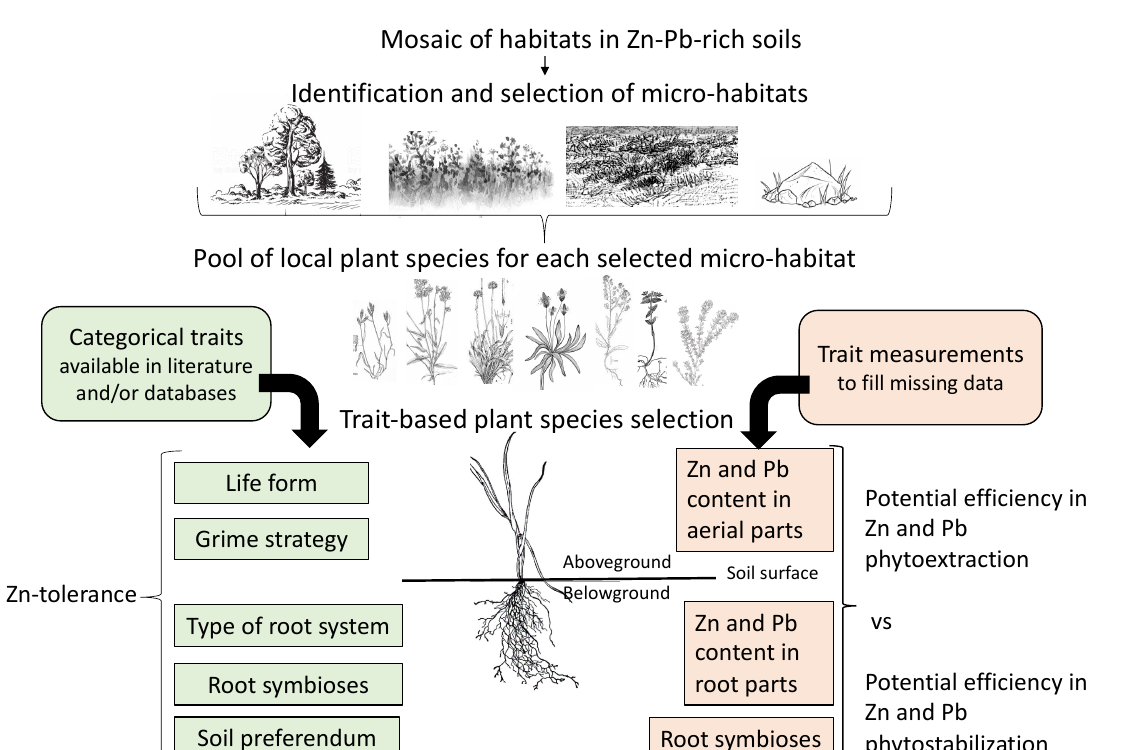
Figure 2. Trait-based grid for local plant selection for phytoremediation of Zn-Pb-rich soils from an ecological restoration perspective.